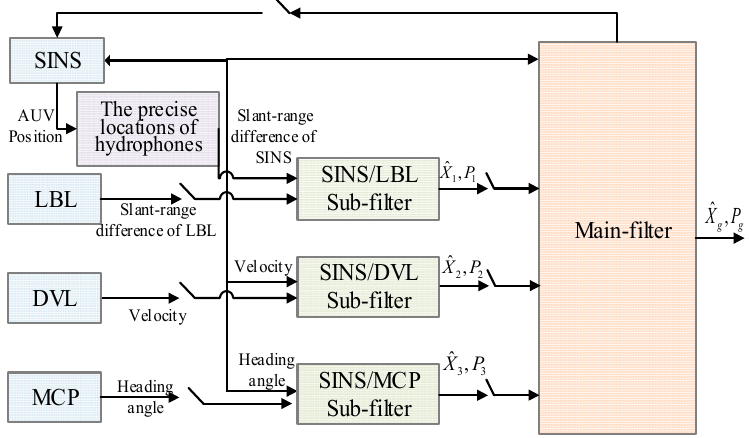
Figure 5. The federal system based on tightly coupled SINS (Strapdown Inertial Navigation System)/LBL (Long Base Line).